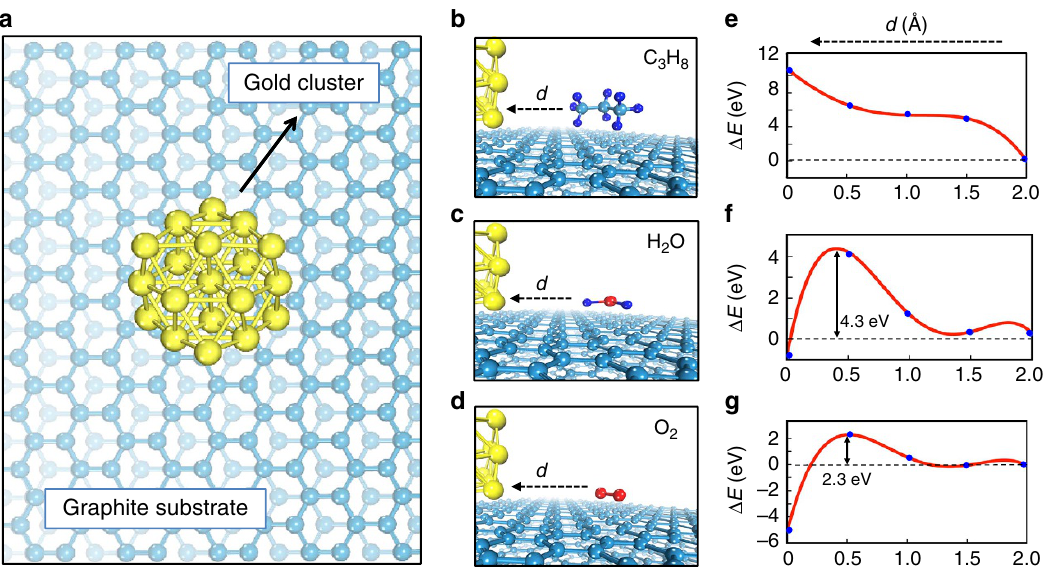
Figure 4 | Ab initio simulations of the interaction between the gold–graphite interface and contaminant molecules. ( a ) A top-view illustration of the model system used for the calculations, consisting of a 19-atom gold cluster on a 3-layer graphite substrate. ( b – d ) Side-view illustrations of propane ( b ), water ( c ) and oxygen ( d ) molecules approaching the gold–graphite interface with decreasing distance d . ( e – g ) Calculated change in the total energy of the system ( D E ) as a function of d for the three scenarios in b – d . While the propane molecule is repelled by the interface due to a steeply increasing energy penalty ( e ), substantial energy barriers of 4.3eV ( f ) and 2.3eV ( g ) are observed for the dissociation of water and oxygen at the interface, respectively. For improved visualization, the quadratic spline interpolation method was utilized in e – g